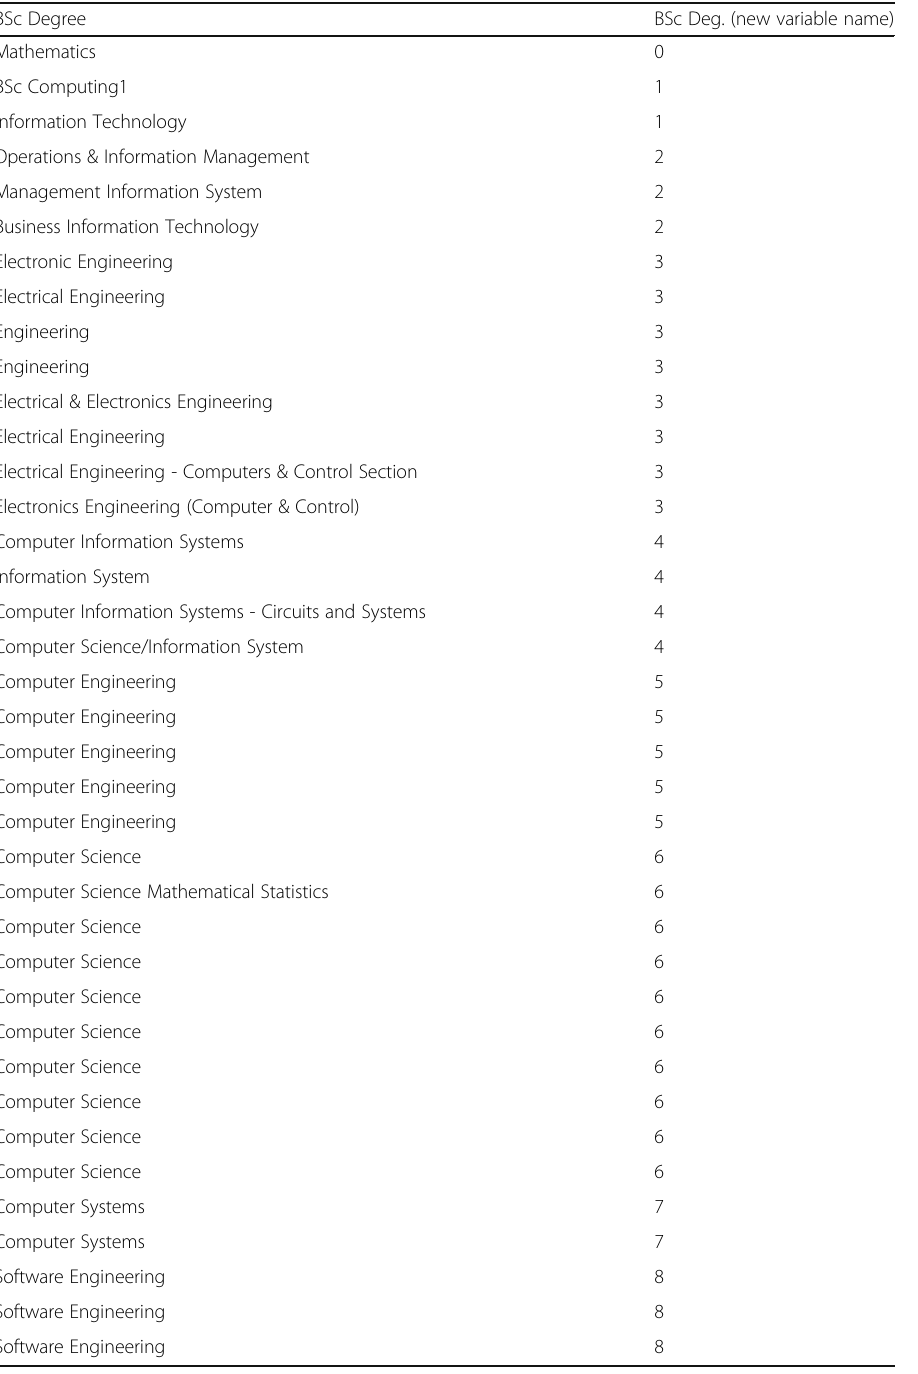
Table 6 Encoding Bachelor Degree Specialization. Noting that specialization that are almost similar to each other were grouped in one